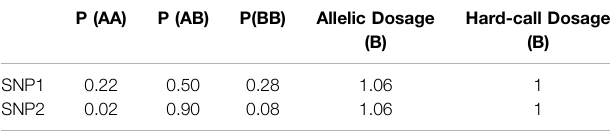
TABLE 5 | Hard-call vs. allelic dosages: genotype probability trios and allelic and hard-called dosages for 2 SNPs of a theoretical